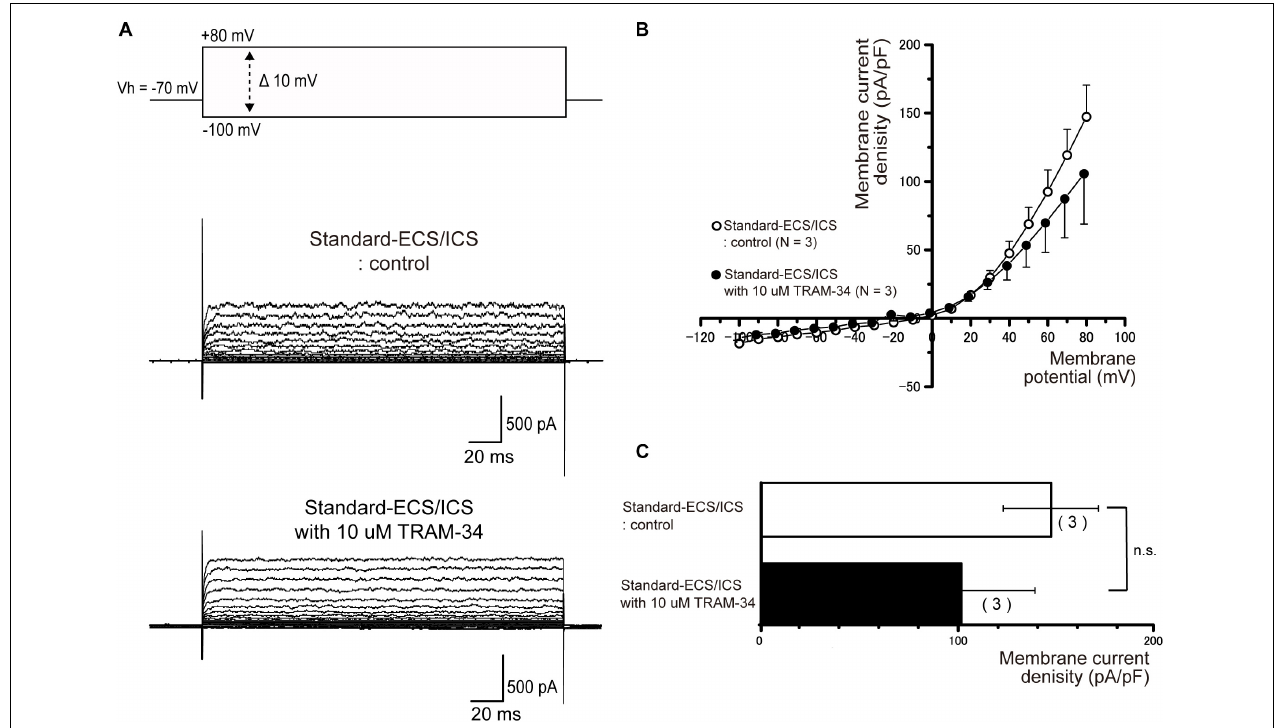
FIGURE 8 | TRAM-34 had no effect on the outward currents. (A) Representative current traces recorded under standard-ECS/ICS conditions without (second upper traces) and with the application of 10 µ M TRAM-34 (third upper traces) are shown. Currents were evoked by applying (400 ms) voltage in 10 mV increments from –100 mV to +80 mV at a holding potential (Vh) of –70 mV (upper traces). (B) Current-voltage (I-V) relationships for the currents recorded under standard-ECS/ICS conditions without (open circles) and with the application of 10 µ M TRAM-34 (filled circles) are shown. Each point represents the mean ± SE current density of the three cells. (C) Summary bar graphs showing current densities under standard-ECS/ICS conditions at a membrane potential of +80 mV without (upper column) and with application of 10 µ M TRAM-34 (lower column). Each column represents the mean ± SE of the three cells.